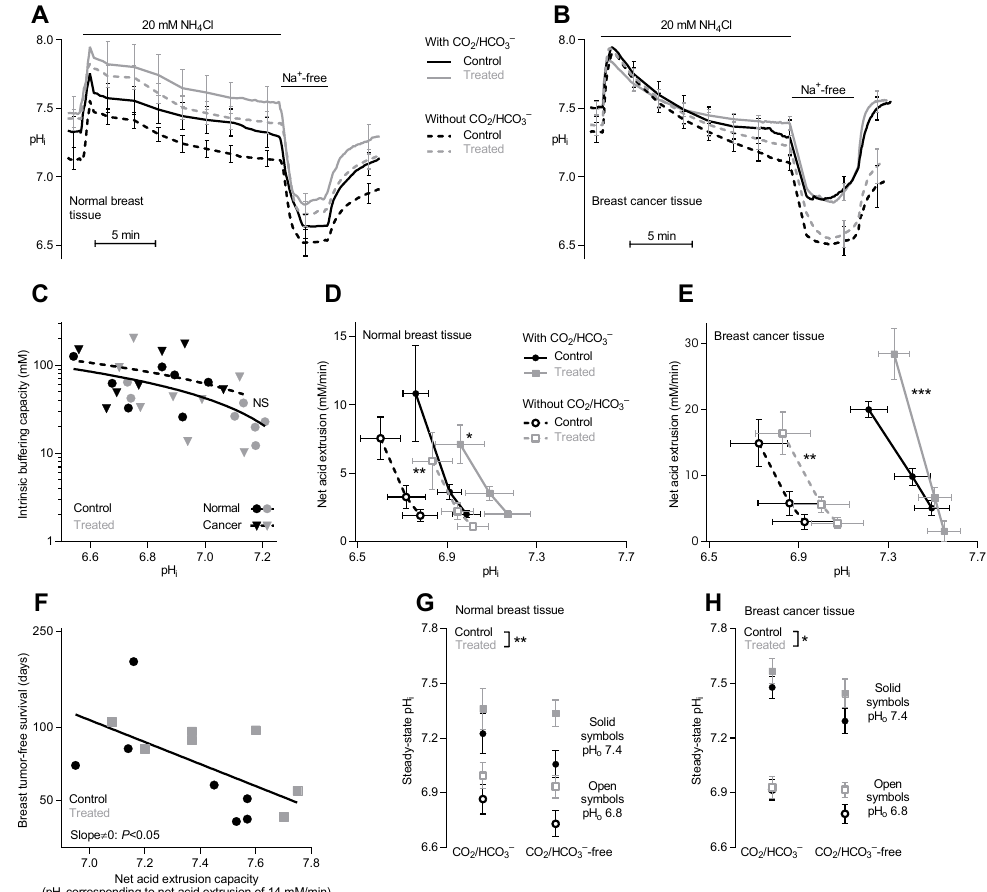
Figure 4. The capacity for net acid extrusion is increased in both normal breast tissue and breast cancer tissue from NaHCO 3 -treated mice compared to control mice. ( A,B ) . Average traces of pH i -dynamics during NH 4 + -prepulse experiments performed on normal breast tissue ( A ) and breast cancer tissue ( B ) from NaHCO 3 -treated mice and control mice ( n = 7). Experiments were conducted in both the presence and absence of CO 2 / HCO 3– . ( C ) . Intracellular intrinsic bu ff ering capacity of organoids of both cancer and normal tissue from NaHCO 3 -treated and untreated mice ( n = 7). Linear regression showed no significant di ff erence in bu ff ering capacity between NaHCO 3 -treated and control mice. ( D,E ) . Cellular net acid extrusion in epithelial organoids isolated from normal breast tissue ( D ) and breast cancer tissue ( E ) displayed as a function of pH i . Experiments were based on tissue from NaHCO 3 -treated mice and control mice ( n = 7) and performed in both the presence and absence of CO 2 / HCO 3– . Data were compared by least-squares linear regression analyses. ( F ). Breast tumor-free survival plotted as function of net acid extrusion capacity displayed as the pH i value corresponding to net acid extrusion of 14 mM / min. The higher the pH i value, the greater the capacity for net acid extrusion. (G,H). Steady-state pH i values measured from normal breast tissue ( G ) and breast cancer tissue ( H ) isolated from NaHCO 3 -treated mice and control mice ( n = 7) and investigated at pH o 7.4 (closed symbols) and 6.8 (open symbols). Data were compared by three-way ANOVA. * p < 0.05, ** p < 0.01, *** p < 0.001 vs. Control under similar conditions or as